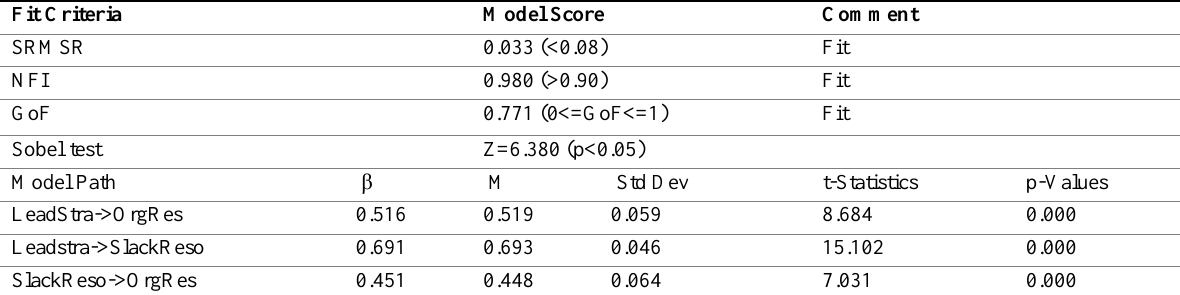
Table 3: Model Fit and Path Coefficients for Slack